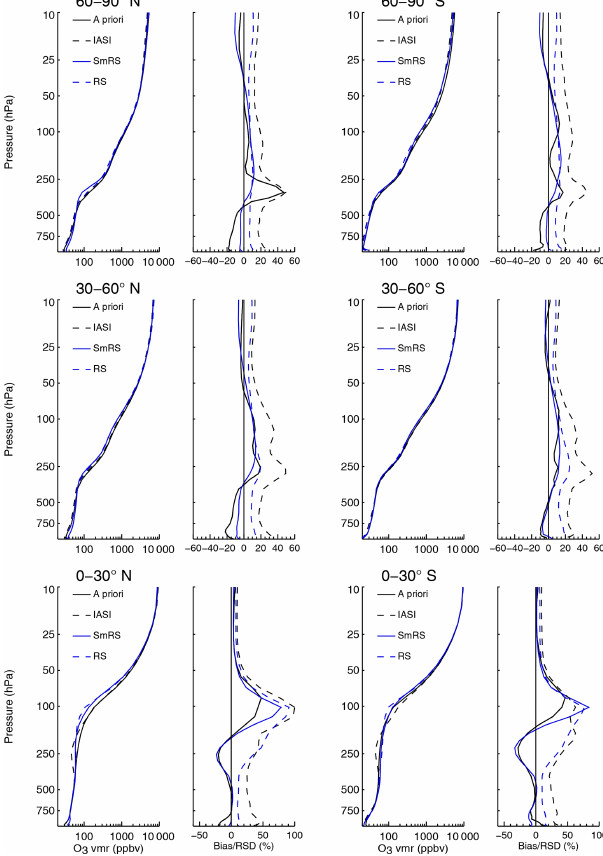
Figure 8. Same as Fig. 7 for SOFRID-O3